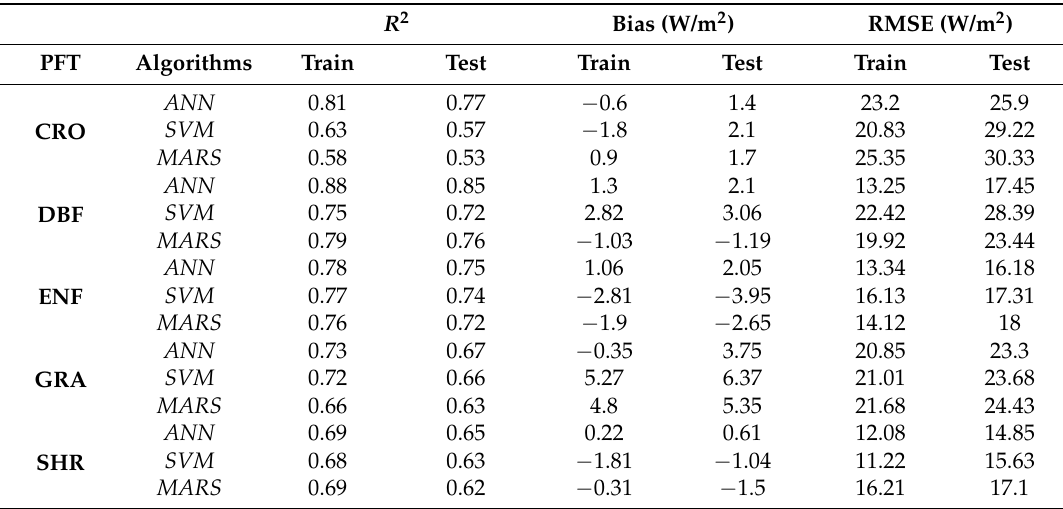
Table 2. Training and validation statistics for the different algorithms based on MERRA data. All R 2 values are significant with a 99% confidence.